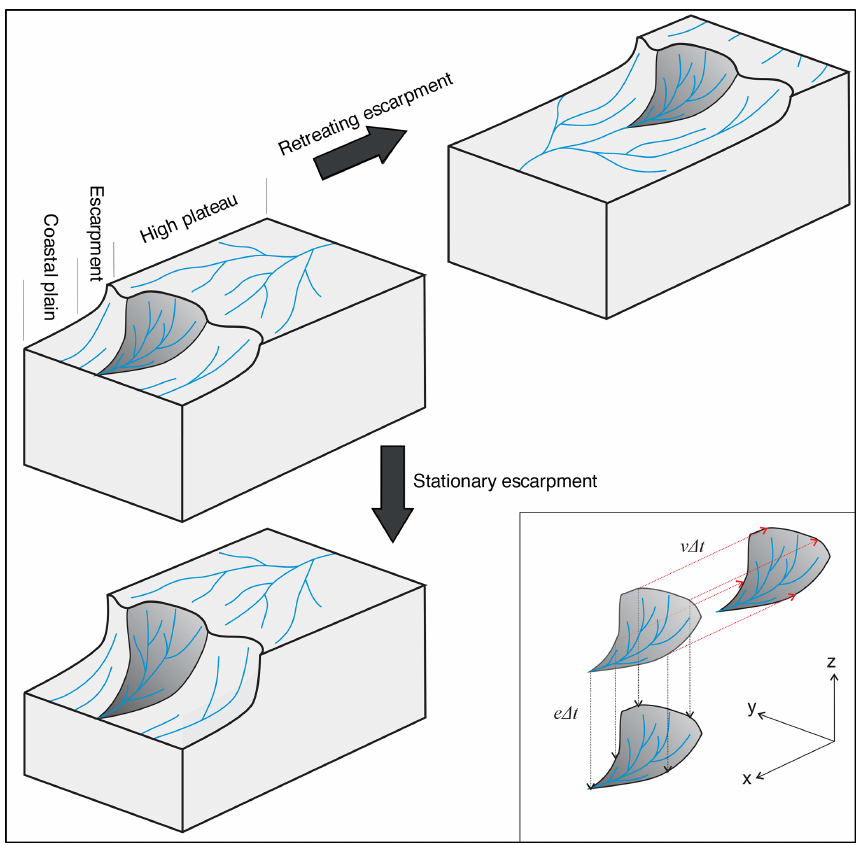
Figure 1. Conceptual diagram showing two scenarios of escarpment evolution: a retreating escarpment or a downcutting escarpment with stationary water divide. The gray surface denotes the surface of an elemental escarpment-draining catchment. Inset is the mathematical representative of the two scenarios as motion relative to the rock. (cid:49)t denotes the unit time, v denotes retreat rate, e denotes a vertical erosion rate, red arrows indicate the horizontal retreat vector, and black arrows indicate the vertical erosion